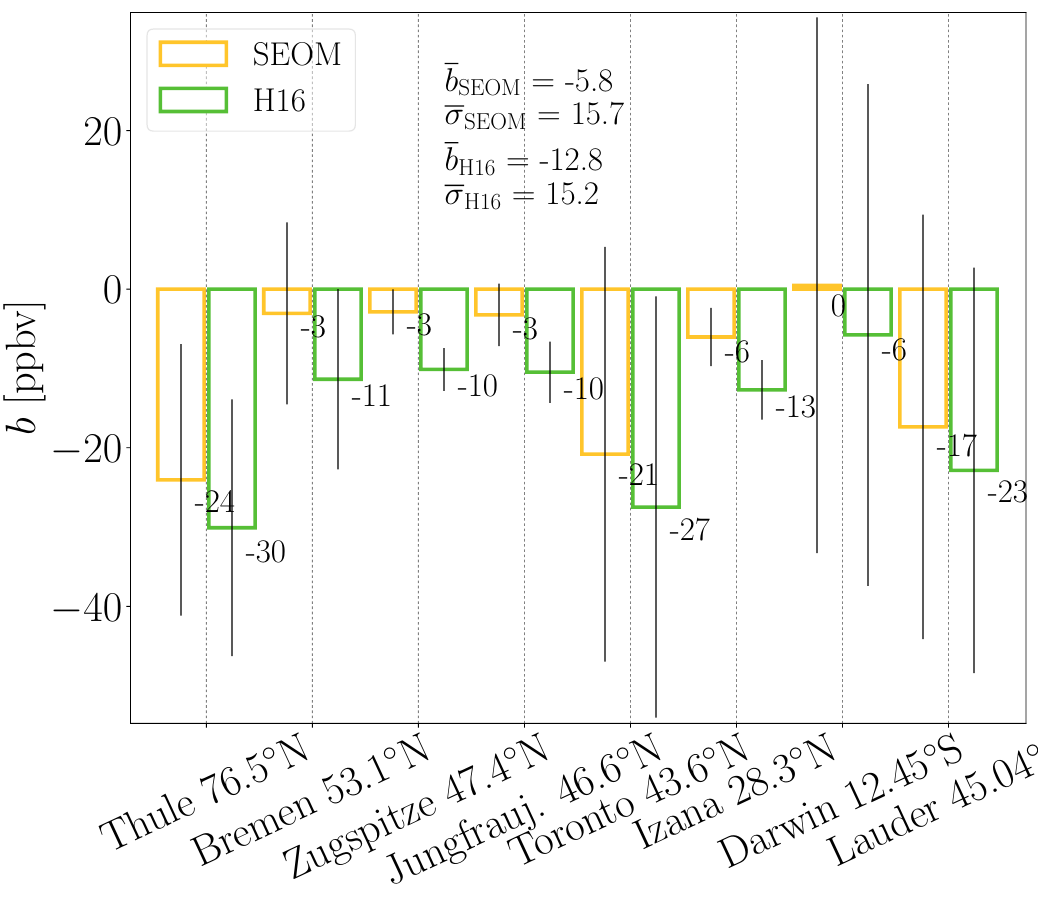
Figure 9. Bias between NDACC/TCCON and SCIAMACHY xCO retrievals within 1000 km (distance weighted) of the ground-based reference sites. Stations Darwin and Lauder belong to TCCON while the others are affiliated to